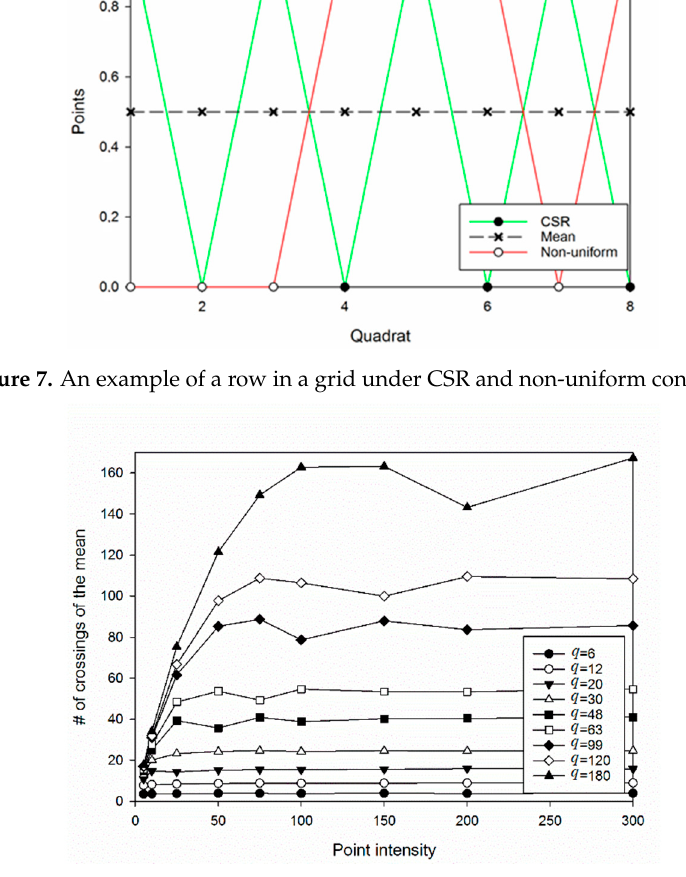
Figure 8. The count of crossings of the mean as a function of point intensity. The drop in the plot may be due to this being the optimal q for the specific point intensity (see text).